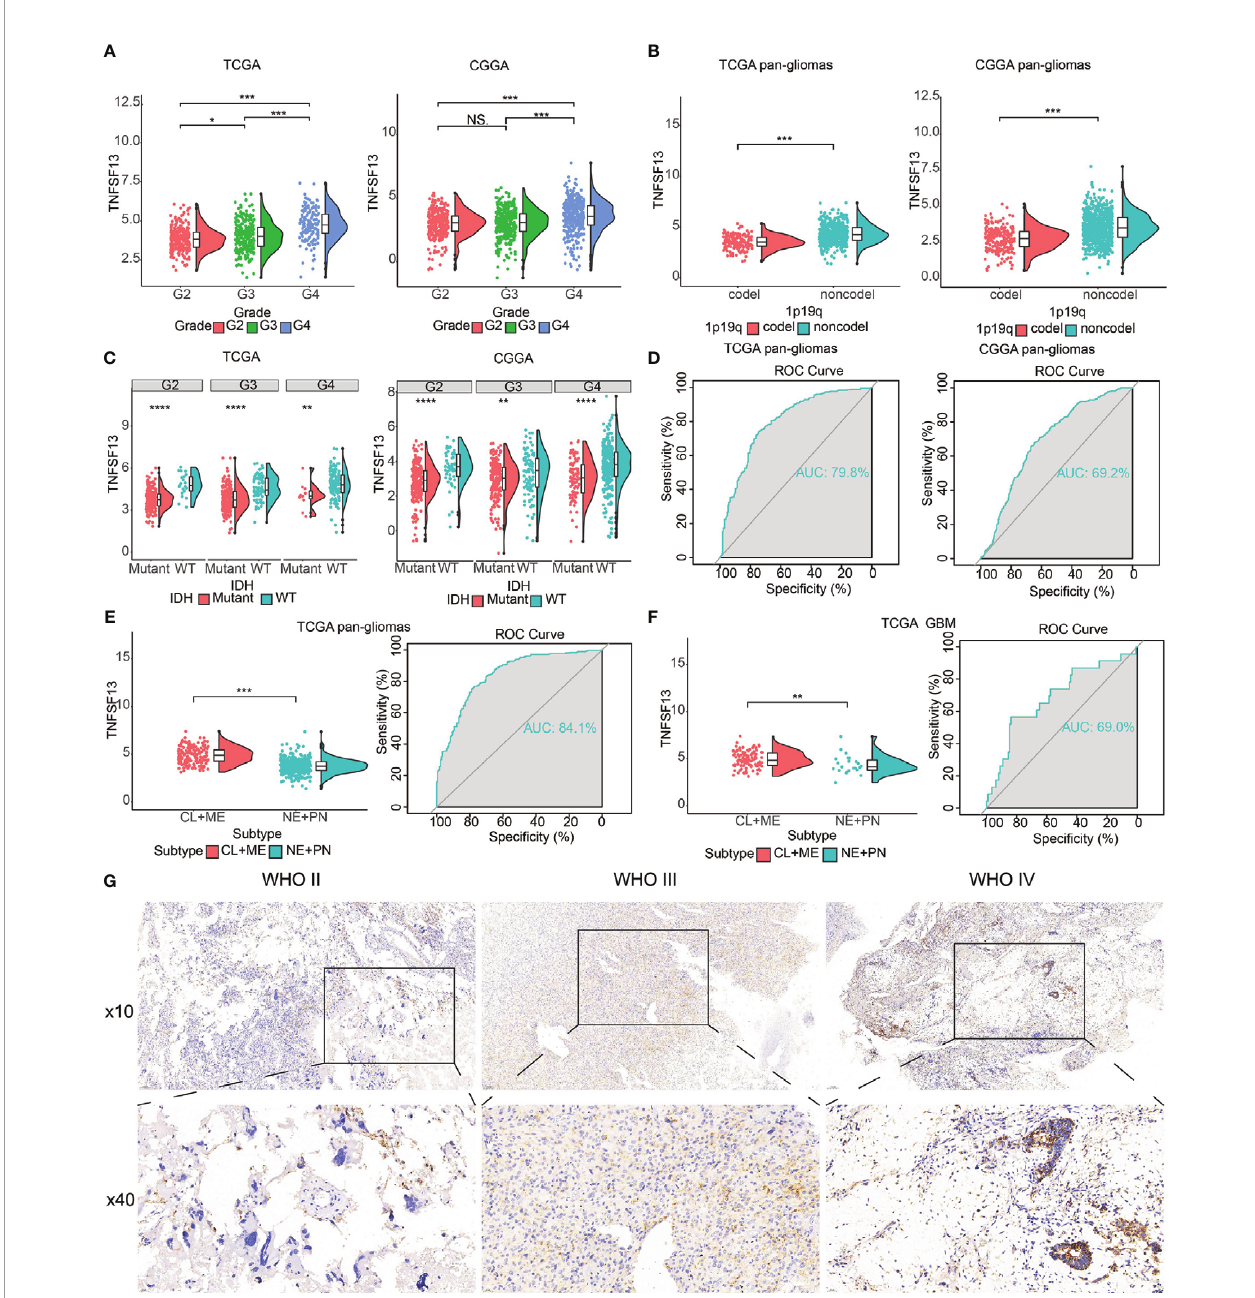
FIGURE 1 | The clinical and molecular characteristics in associations with TNFSF13 expression. (A) The expression levels of TNFSF13 in different WHO grades from TCGA and CGGA datasets. (B) TNFSF13 expression increased in 1p/19q non-codeletion glioma cases. (C) TNFSF13 expression levels in different IDH states from TCGA and CGGA datasets. (D) Receiver operating characteristic (ROC) curve showed 79.8 and 69.2% sensitivity and speci fi city of TNFSF13 to predict IDH wild- type gliomas from TCGA and CGGA, respectively. (E) The TNFSF13 expression levels in pan-gliomas of different molecular subtypes from TCGA dataset. ROC curves to assess sensitivity and speci fi city of TNFSF13 expression to predict more invasive subtype gliomas. (F) The TNFSF13 expression levels in GBM of different molecular subtypes from TCGA dataset. ROC curve showed 80.4% sensitivity and speci fi city of TNFSF13 expression to predict more invasive subtype gliomas. (G) Typical images of IHC staining for TNFSF13 in different pathological grades of glioma samples from Xiangya cohort. NS, not statistically signi fi cant, *P <.05, **P <.01, ***P <.001, ****P